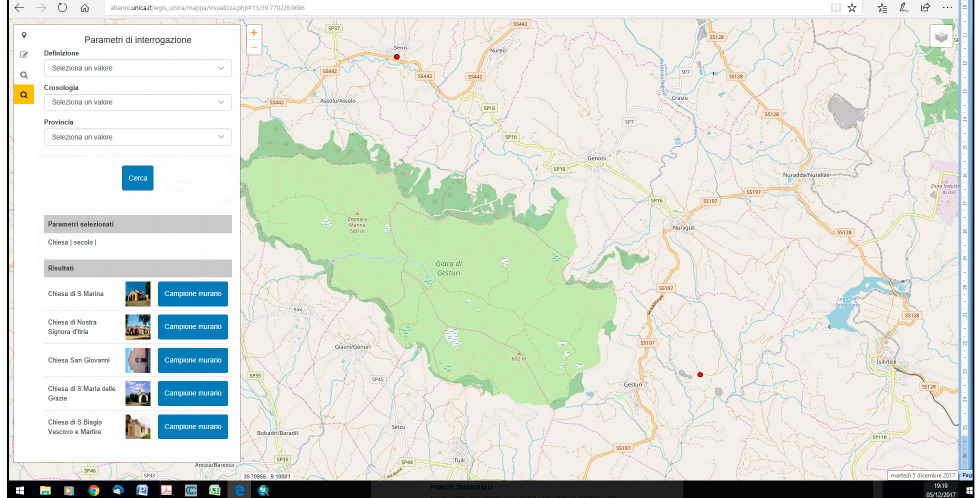
Figure 10. Query Result.